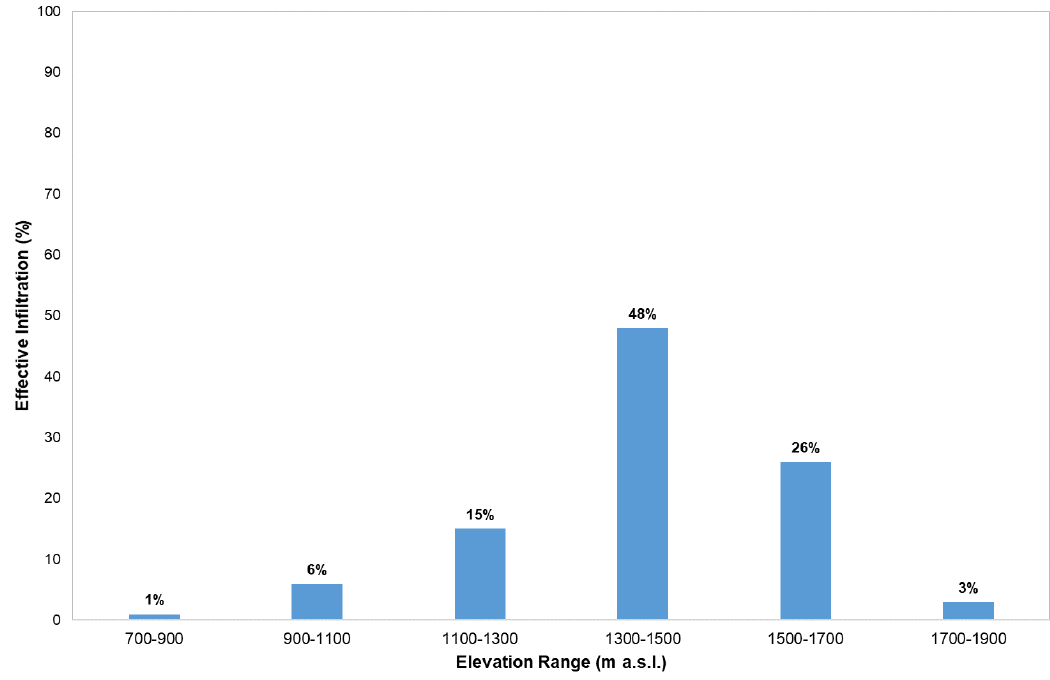
Figure 7. Bar plot of effective infiltration (%).